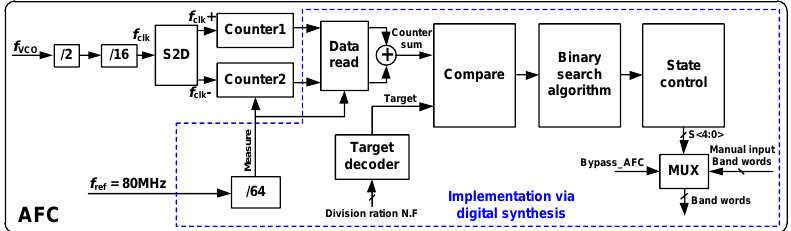
Figure 10. Structure of the proposed auto frequency calibration